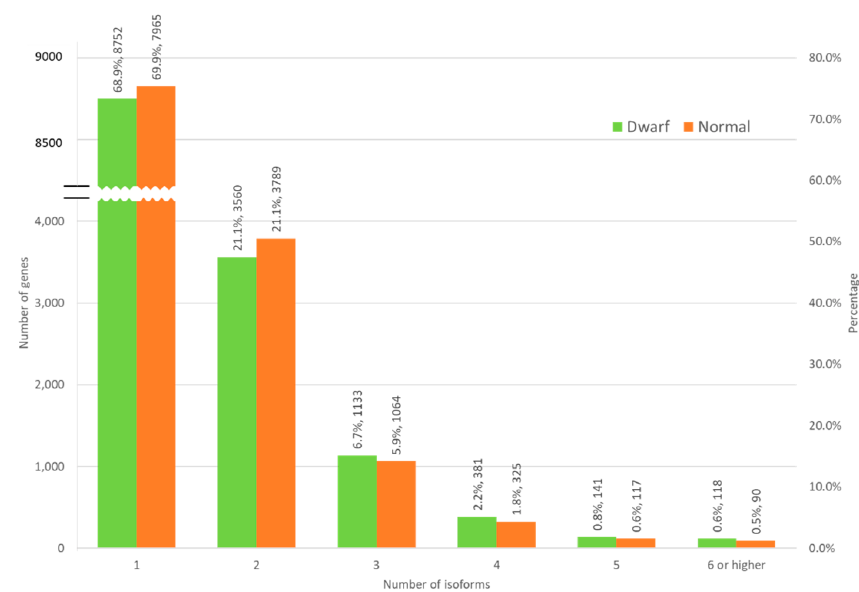
Figure 3. Isoform distribution. The chart represents the number of genes exhibiting the number of isoforms where the maximum number of genes have single unigenes and more than 30% of the genes have at least two or more isoforms.